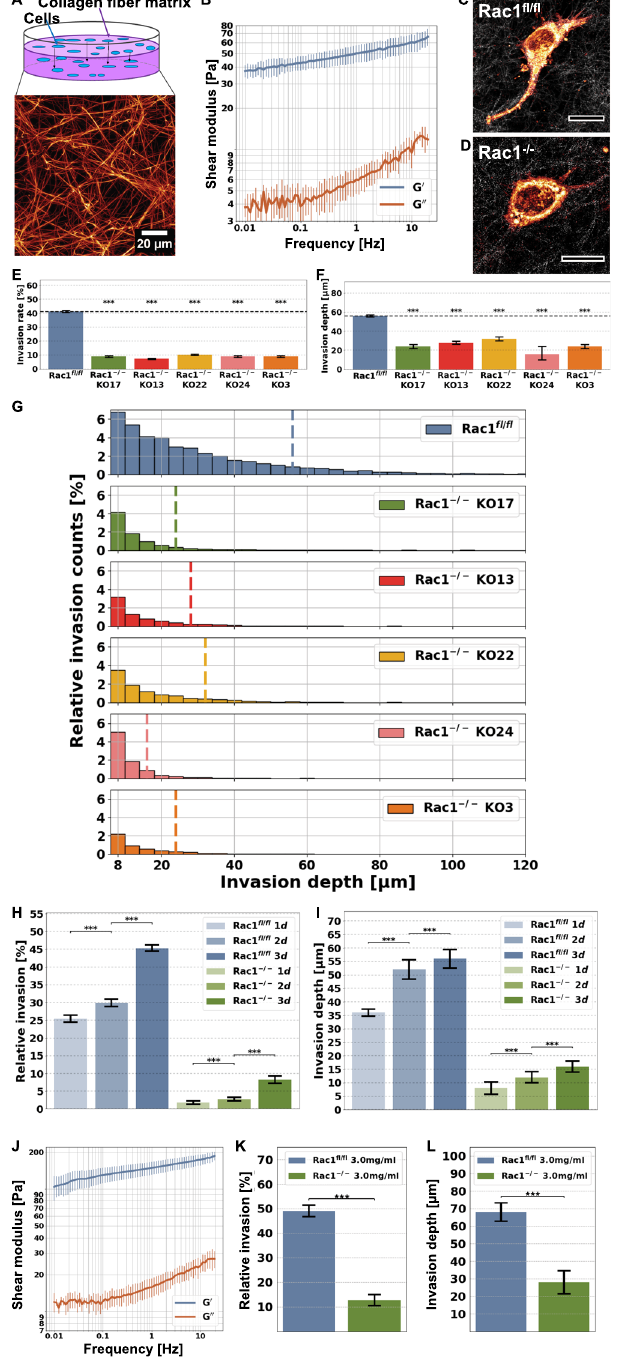
Figure 2. Effect of Rac1 on cellular motility into an engineered 3D microenvironment. ( A ) Experimental setup of the invasion assay, where the cells are seeded on top of the 3D collagen fiber matrix scaffold. (Bottom image) Laser scanning confocal image of a 3D extracellular matrix stained with TAMRA with a collagen concentration of 1.5 mg/ml and a pH of 7.4. Scale bar is 20 µ m. ( B ) Plate rheology measurements of 1.5 mg/ml 3D collagen matrices revealed a frequency dependent shear moduli G ′ (storage modulus) and G ″ (loss modulus). Representative image of an invasive Rac1 fl/fl cell ( C ) and an invasive Rac1 − / − cell ( D ). Scale bars are 10 µ m. ( E ) Average percentage of invasive Rac1 − / − cell clones and Rac1 fl/fl cells and their invasion depths ( F ) that were migrated in the 3D extracellular matrix after three days of culture at 37 °C, 95% humidity and 5% CO 2 . ( G ) Time course invasion assays: invasion depth profile of the invasive Rac1 fl/fl cells (blue) and Rac1 − / − cell clones KO17 (green), KO13 (red), KO22 (yellow), KO24 (pink) and KO3 (orange). ( H ) Average percentage of invasive Rac1 − / − cell clones (green) and Rac1 fl/fl (blue) and their invasion depths ( I ) after 1 d, 2 d and 3 d. ( J ) Plate rheology measurements of 3.0 mg/ml 3D collagen matrices revealed frequency dependent shear moduli G ′ and G ″ . ( K ) Average percentage of invasive Rac1 − / − cell clones and Rac1 fl/fl cells and their invasion depths ( L ) that migrated into the 3D 3.0 mg/ml collagen matrix after three days of culture. *** p < 0.001and NS = not